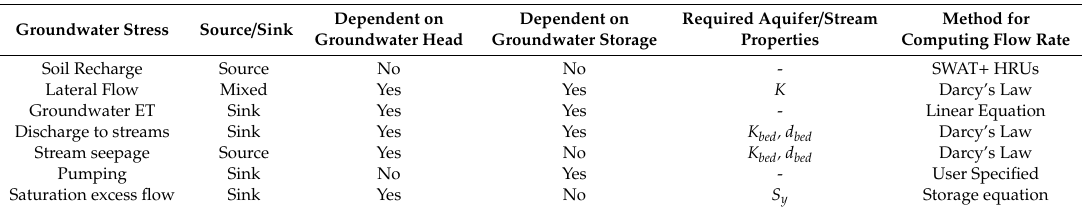
Table 1. Groundwater stresses included in the gwflow module. Specific details regarding the method for computing each stress are presented in Section